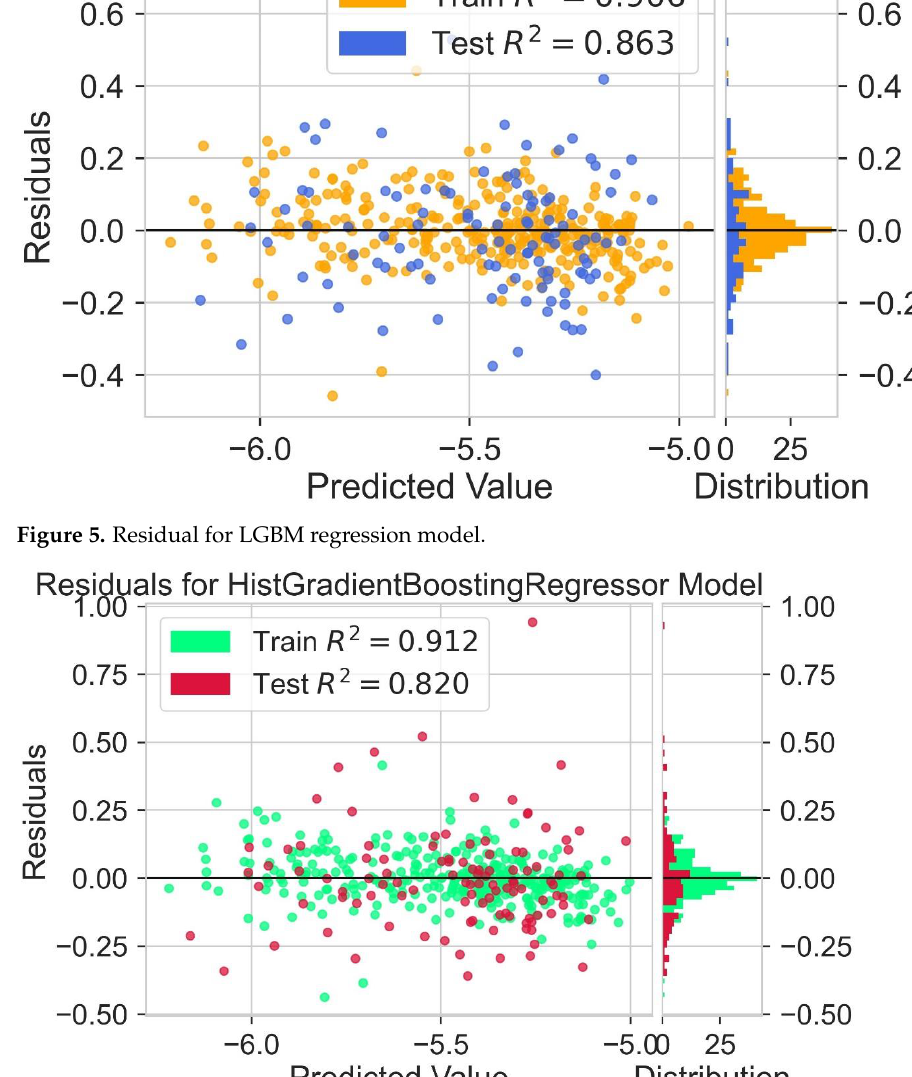
Figure 6. Residuals for Hist gradient booting regression model. A scattered plot between the experimental value and expected value of HOMO using the LGBM Regression model and Hist gradient regression model is shown in Figure 7 and Figure 8, respectively. The scatter plot is drawn between the residuals for models and the experimental or predicted value. The majority of values are in the low range, close to zero, which is a clear indication of accurate results. The values for train residues and the values for the test residues are also close to zero. The results show that both LGBM Regression model and the Hist Gradient Boosting Regression model are the best models for regression